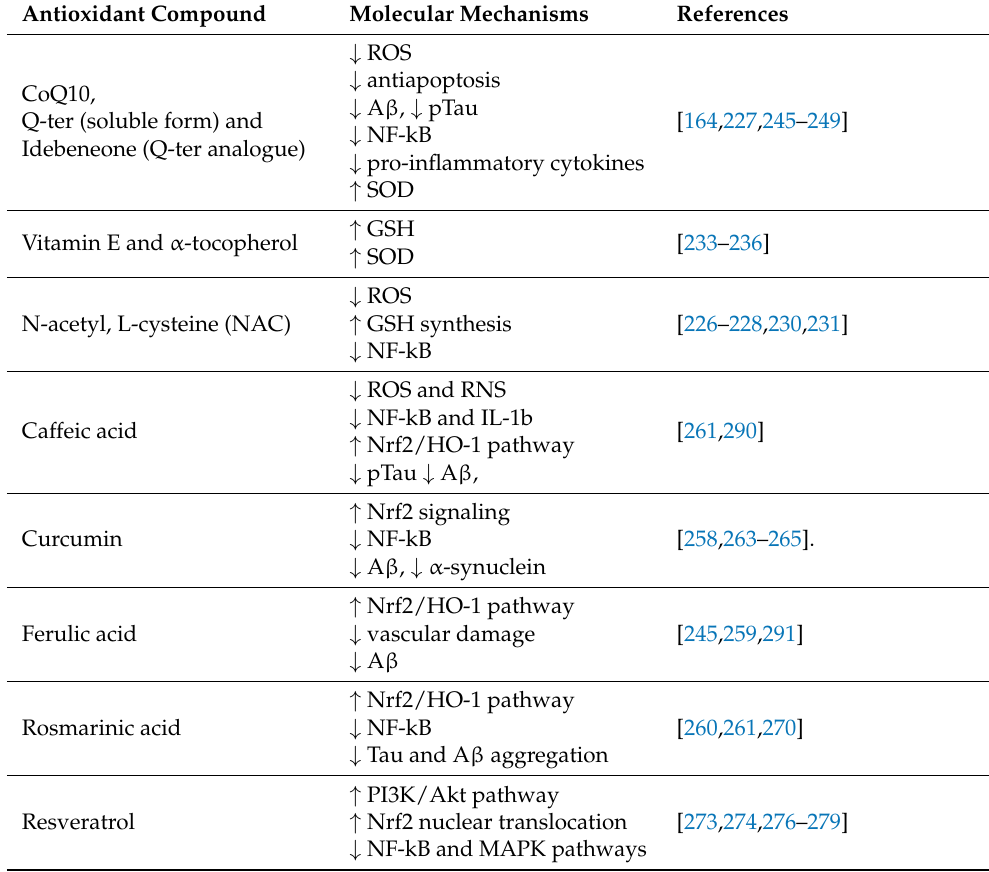
Table 1. Antioxidant molecules showing efficacy in counteracting both hearing loss and Alzheimer’s disease and their molecular mechanisms ( ↑ increase; ↓